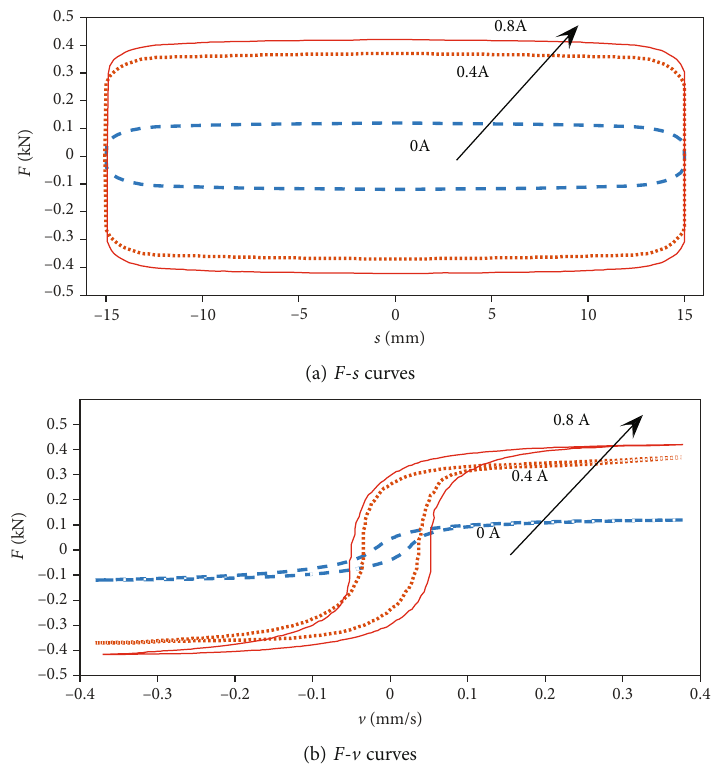
Figure 5: F - s curves and F - v curves of di ff erent current values under 4 Hz and 15 mm excitation.